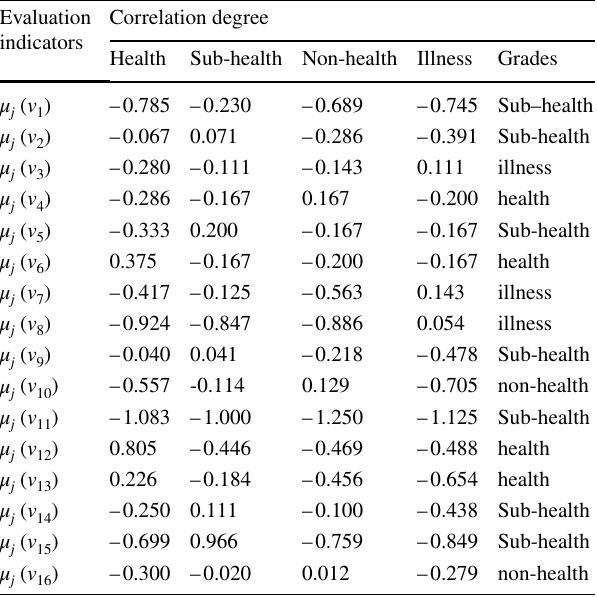
Table 2 Health indicator evaluation results of Huangchuan River